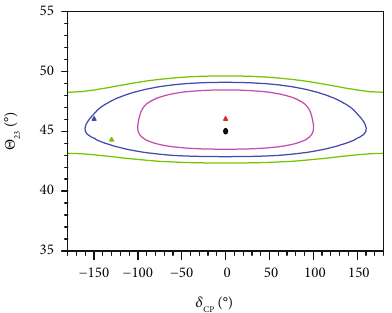
, δ Figure 4: Con fi dence regions in the ( θ 23 CP ) plane, obtained by using the migration matrices of pure QE + RES + DIS and QE + RES + DIS -like events. The circle ( α = 1 ) shows the true value of the oscillation parameters while the blue ( α = 0 ), red ( α = 0 : 3 ), and green ( α = 0 : 5 ) triangles represent the best fi t values of α = 0 : 3 and α = 0 : 5 nearly overlap. This indicates